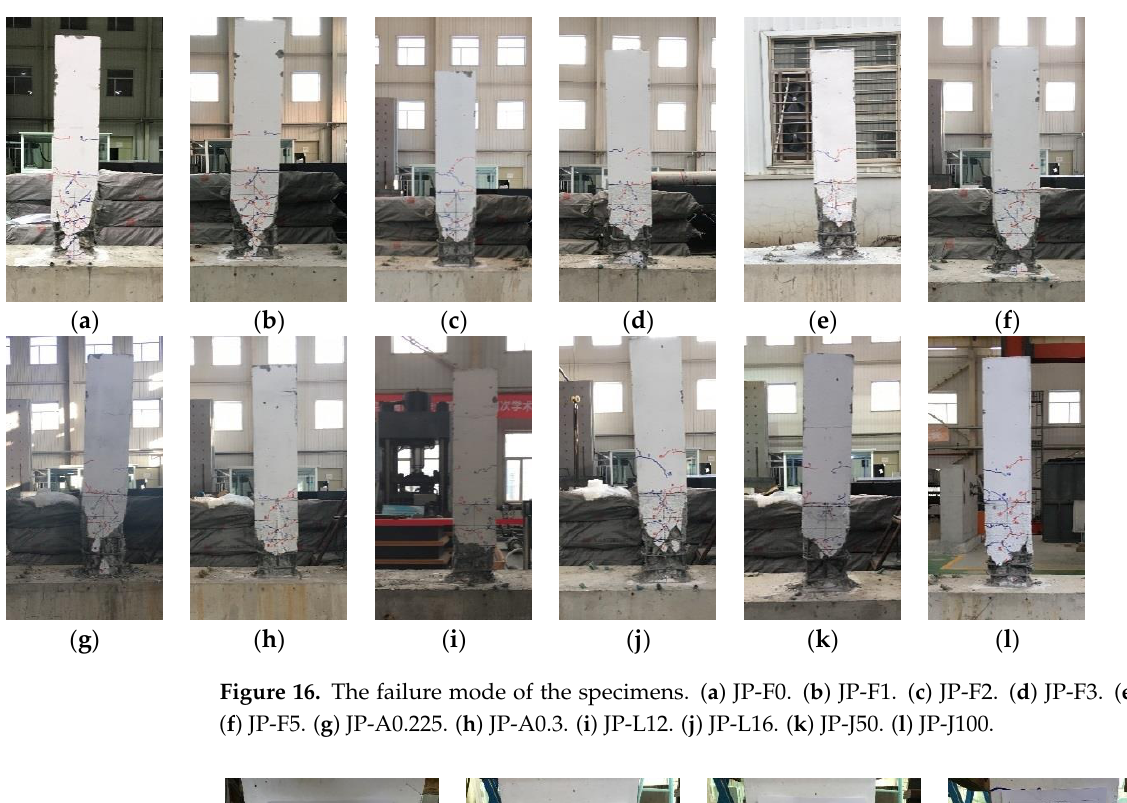
Figure 16. The failure mode of the specimens. ( a ) JP-F0. ( b ) JP-F1. ( c ) JP-F2. ( d ) JP-F3. ( e ) JP-F4. ( f )